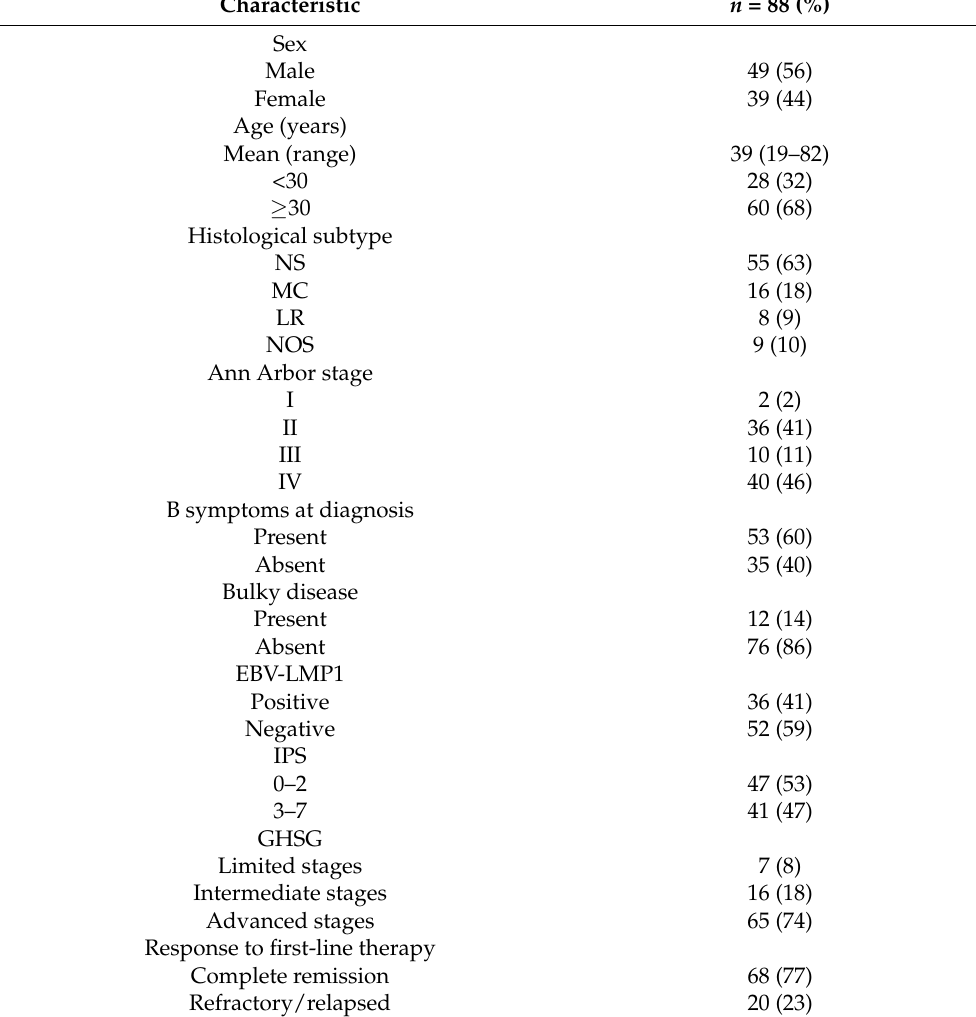
Table 1. Patient demographics and